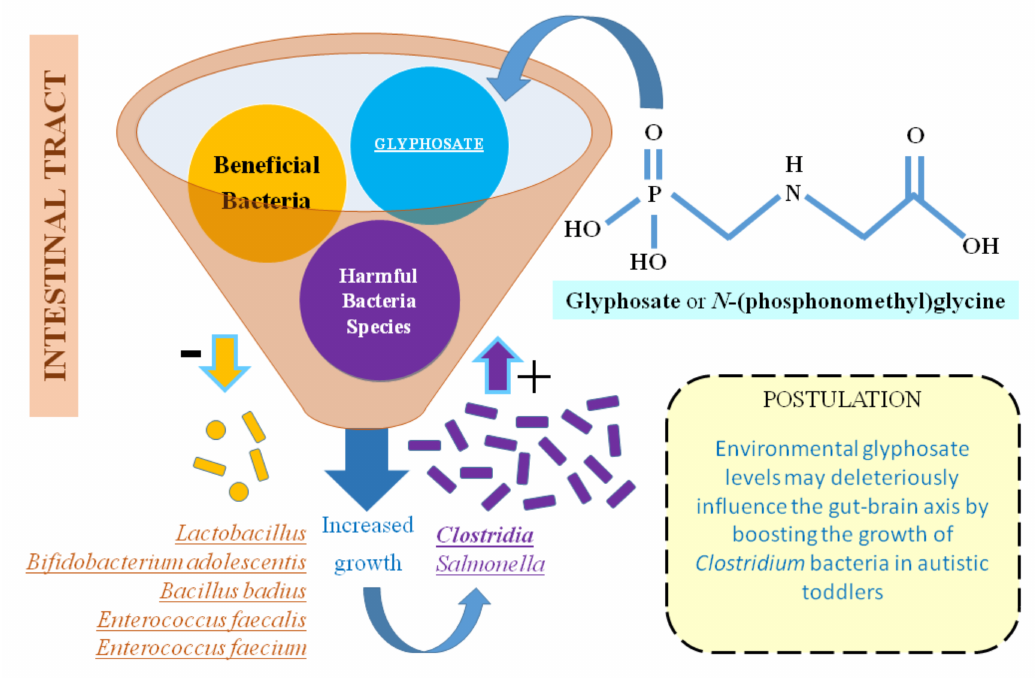
Figure 2. Glyphosate (GLY) may hypothetically contribute to ASD etiology by deleteriously influencing gut microbiome. Literature evidence suggests the link between Clostridium bacteria and developing and/or aggravating autism among children, highlighted by the present systematic review. Environmental exposure to GLY could contribute to such interplay by affecting the growth of normal gastrointestinal flora and therefore, allowing the growth of harmful bacteria species such as Clostridium, which are not sensitive to this